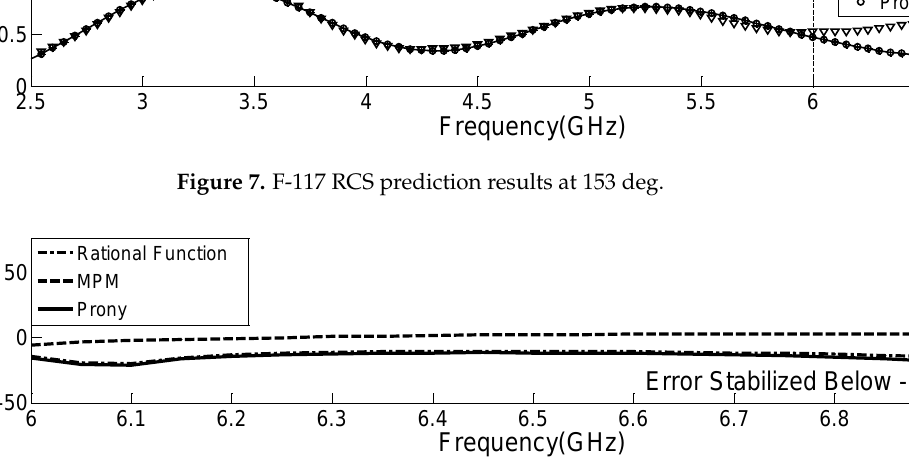
Figure 8. F-117 RCS prediction errors at 153 deg.